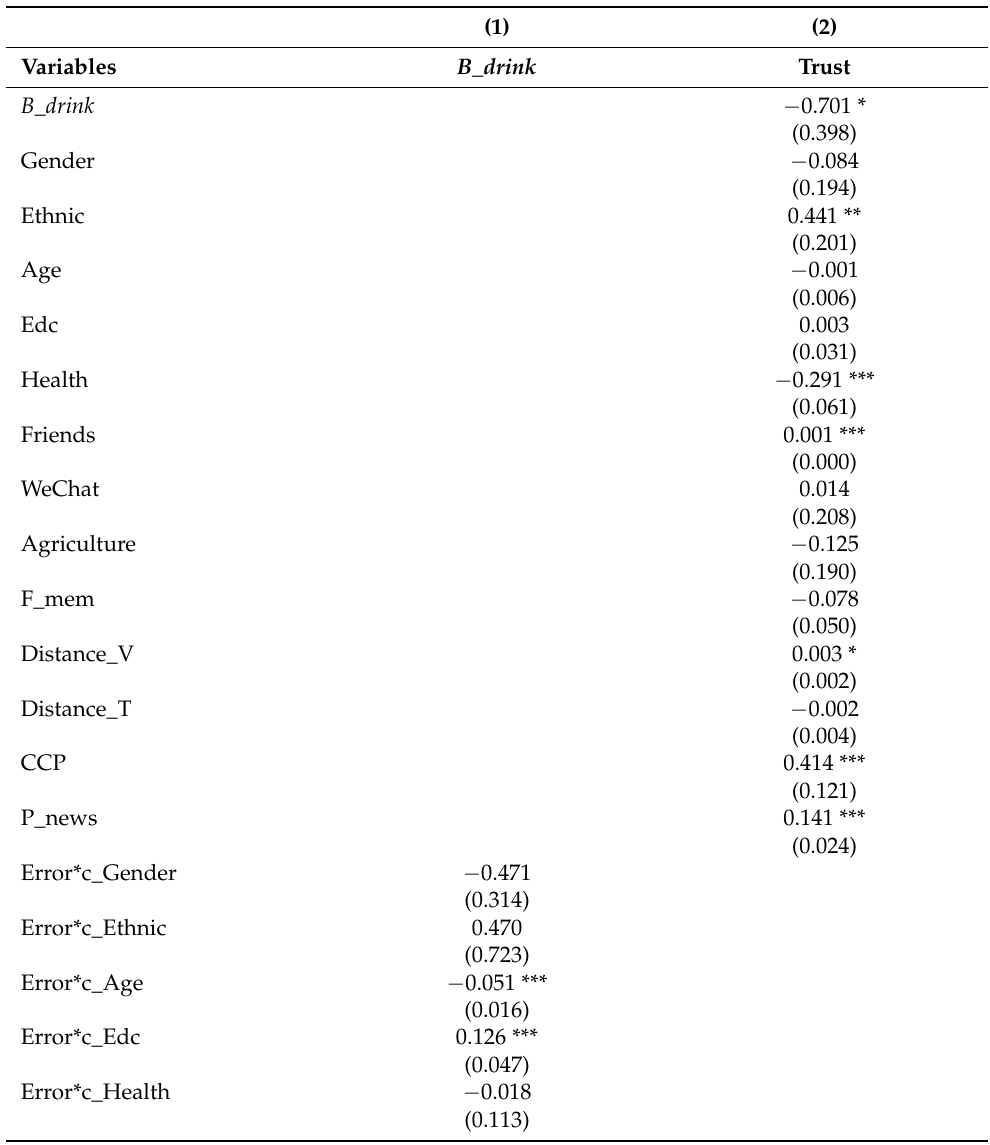
Table 5. Identifying causal effects based on Lewbel’s